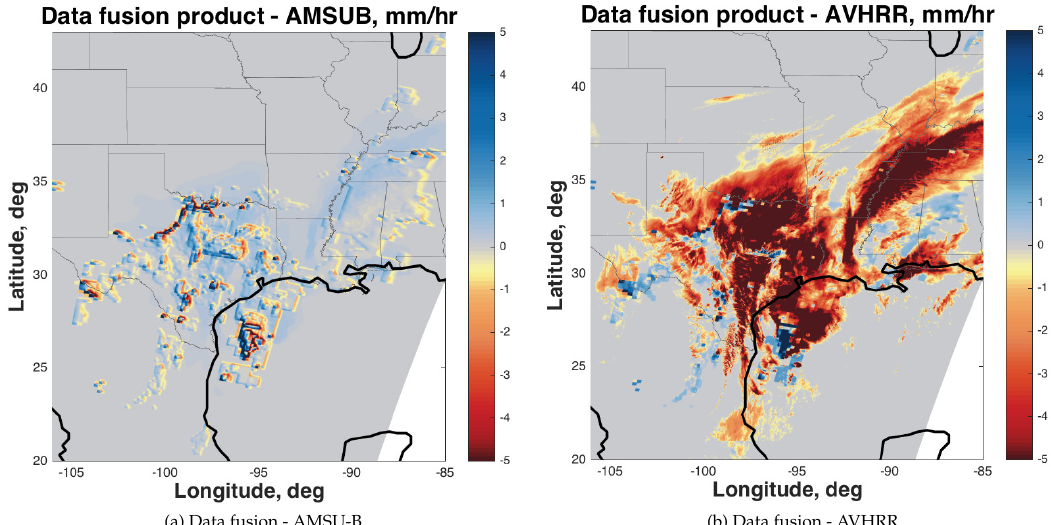
Figure 4. The event on 9 January 2013. ( a ) The difference between data fusion product and AMSU-B. ( b ) The difference between data fusion product and AVHRR.